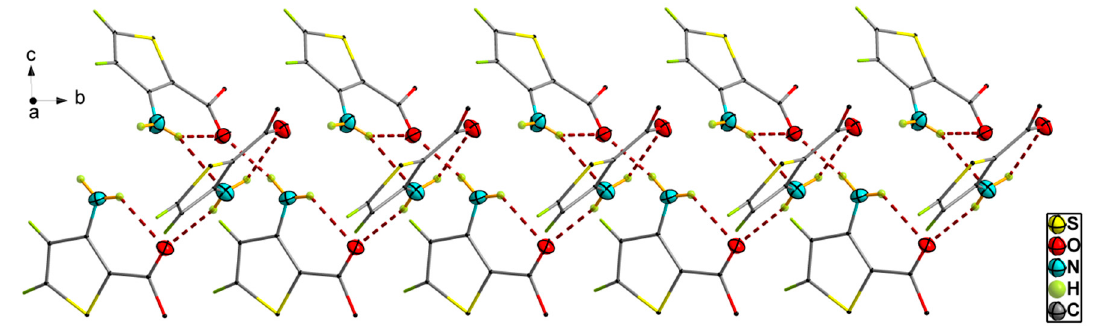
Figure 2. Strong N–H ··· N and N–H ··· O hydrogen bond interactions indicated by dash line in matc. Methyl groups are omitted for clarity. Table 2. Hydrogen bond and weak interactions of matc.